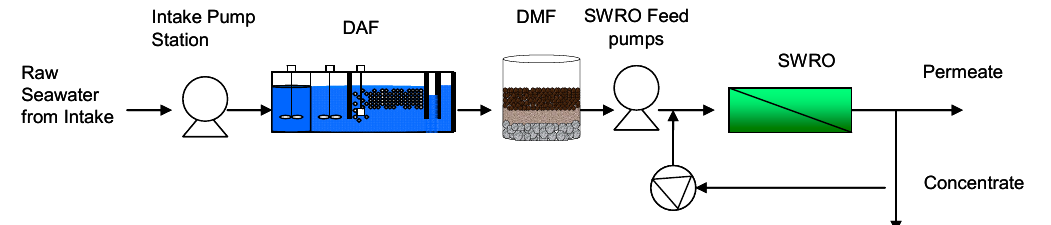
Figure 18. Seawater RO desalination system at the Ras Al Khair SWRO plant [95]. Previously published as part of the International Desalination Association (IDA) World Congress Proceedings, Dubai, 2019 The conductivity of raw seawater varied from 61,200 to 66,300 μ S/cm. On the other hand, the conductivity of feed water was lower (from 60,500 to 64,000 μ S/cm) than that of raw seawater because the brine water of the second pass was mixed with the raw sea- water. The 15-min silt density index (SDI 15 ) value fluctuated and varied from 2.0 to 4.0 (except in the startup period). The average value of SDI 15 was 2.8, and this value was con- sidered normal compared with the other desalination plants located by the Arabian Gulf.